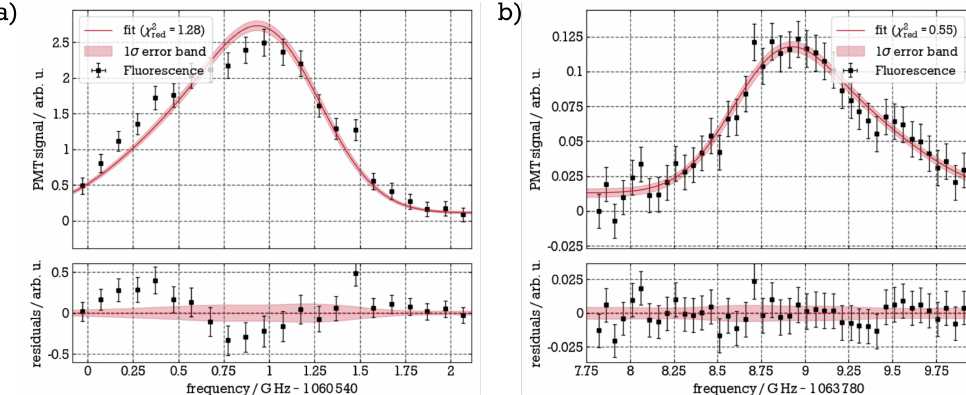
Figure 4. Anticollinear and collinear measurements of the reference transition 2 3 S 1 ( F = 5 / 2 ) → 2 3 P 2 ( F = 7 / 2 ) evaluated with the asymmetric Gaussian fit-model. In the collinear setup ( b ), the laser passed the optical detection region twice, but only one way contributes to the signal. Hence, the signal-to-noise ratio is worse compared to the anticollinear geometry ( a ). The anticollinear measurement was performed subsequently to the collinear measurement. Only the mirror on top of the vertical SPECTRAP beamline was removed. The difference between the main and the satellite peak in the asymmetric Gaussian profile was fixed, but with opposite sign for the two